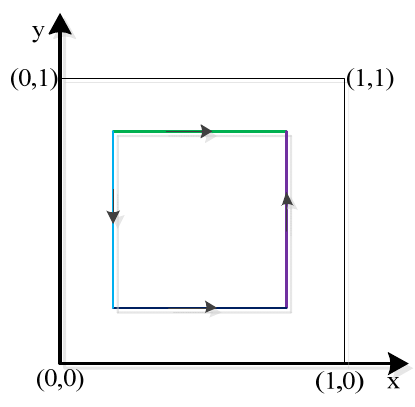
Figure 7. System evolution path of scenario 3.